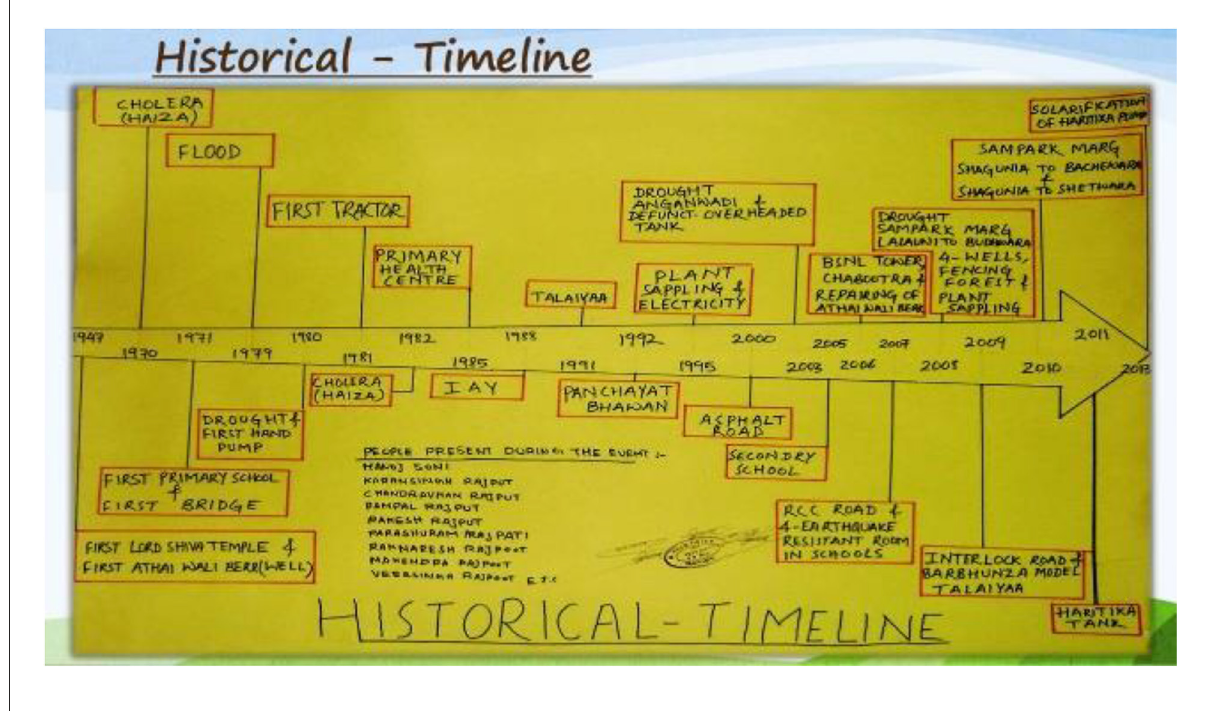
FIGURE4 Historical timeline (shagunia maph village